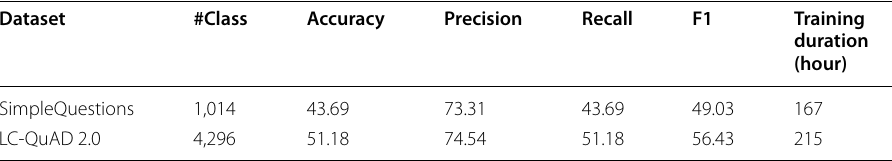
Table 5 The performance of entity detection task using UDP-based feature (in percent) Dataset #Class Accuracy Precision Recall F1 Training SimpleQuestions LC-QuAD 2.0